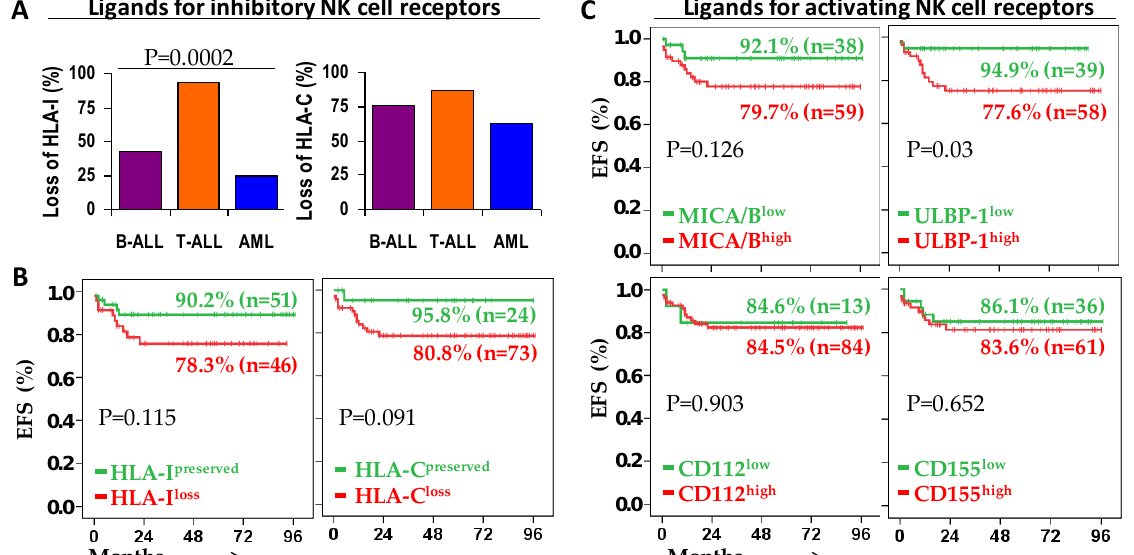
Figure 3. Event-free survival (EFS) of patients according to the expression of ligands for NK cell receptors. ( A ) Frequency of HLA-I and HLA-C loss in B-ALL, T-ALL and AML patients. HLA loss was computed when the mean fluorescence intensity (MFI) expression of HLA on leukemic blast cells was lower than that observed on the normal counterpart cells. P estimated with the Chi-squared test. ( B ) Kaplan – Meier and log-rank tests for EFS of acute leukemia patients according to the low or high expression of ligands for activating NK cell receptors MICA/B (ROC, AUC = 0.53, cutoff = 108.5, sensitivity = 80.0, and specificity = 51.0), ULBP-1 (ROC, AUC = 0.60, cutoff = 140.1, sensitivity = 86.6%, and specificity = 60.1%), CD112 (ROC, AUC = 0.55, cutoff = 1640, sensitivity = 66.0%, and specificity = 55.0%) and CD155 (ROC, AUC = 0.54, cutoff = 326.1, sensitivity = 56.0, and specificity = 62.2). ( C ) Kaplan – Meier and log-rank tests for EFS of acute leukemia patients according to the loss or preservation of HLA-I and HLA-C.